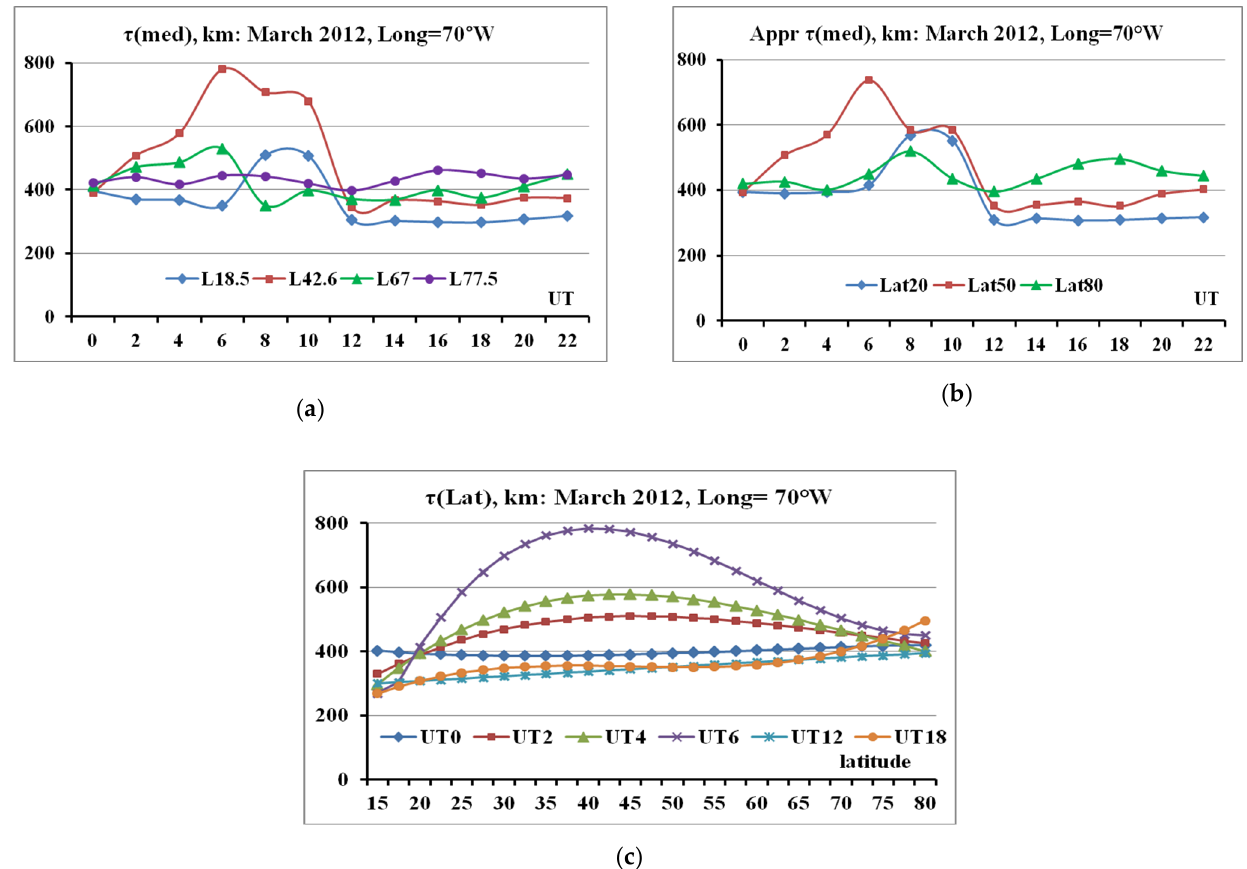
Figure 3. Diurnal variation of ( a ) experimental medians of τ for four ionosonde stations, ( b ) τ medians for three arbitrary latitudes according to the polynomial approximation and ( c ) latitudinal distribution of the equivalent slab thickness at different hours of the day.